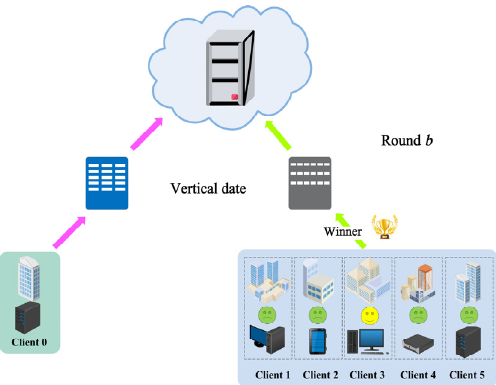
Figure 7. Two − dimensional auction in federated learning with vertical data.